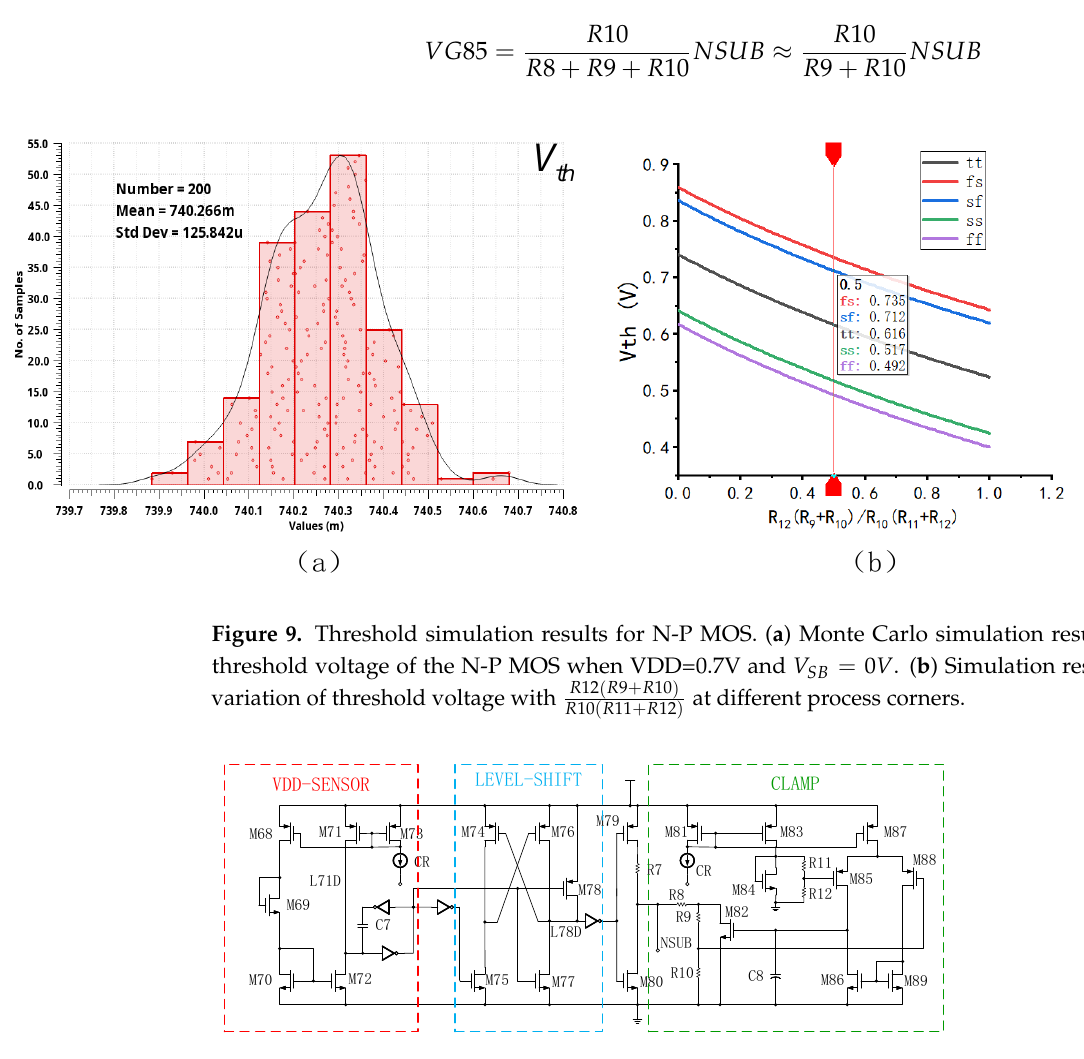
Figure 10. NSUB-REG circuit